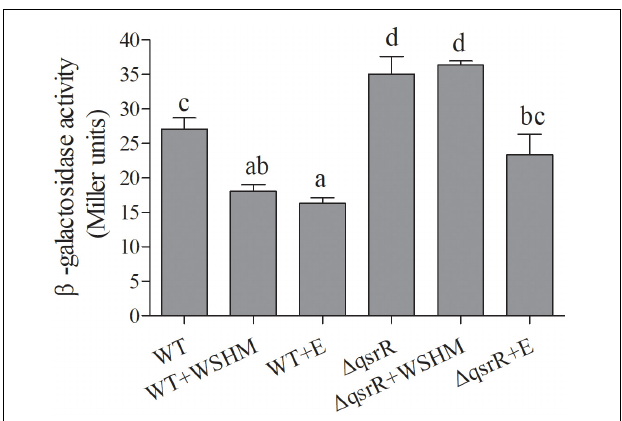
FIGURE 4 | Expression of P expR - lacZ in S. meliloti 8530 (WT) and S. meliloti (cid:49) qsrR mutant treated with either 500 mg L − 1 WSHM or 2% alfalfa seed exudates (E), respectively. Alfalfa seed exudates were used to assess whether WSHM could repress expR expression in a manner similar with plant signal. Data are expressed as average ± SEM for three replicates. Different letters indicate statistical significance as assessed by Duncan tests ( P <